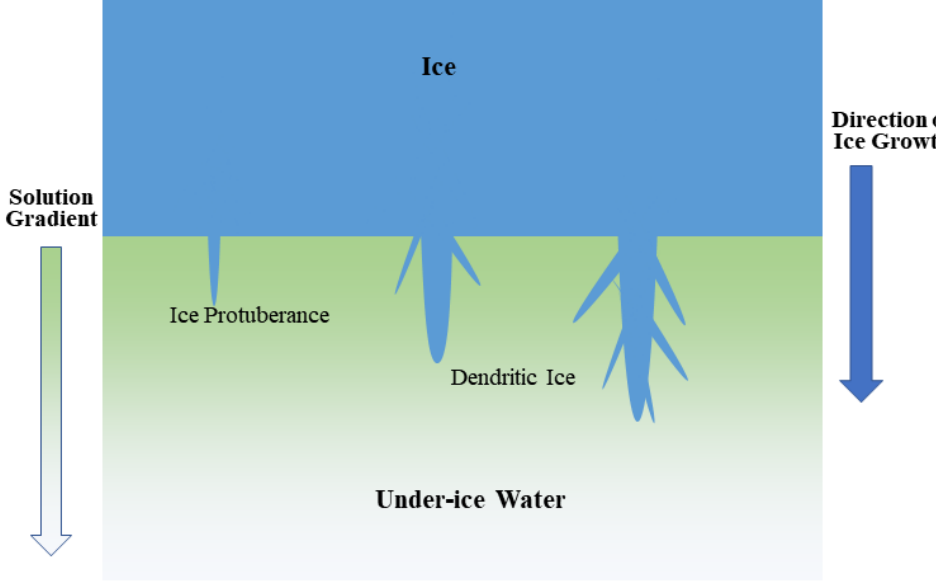
Figure 6. Schematic diagram of the growth of dendritic ice.